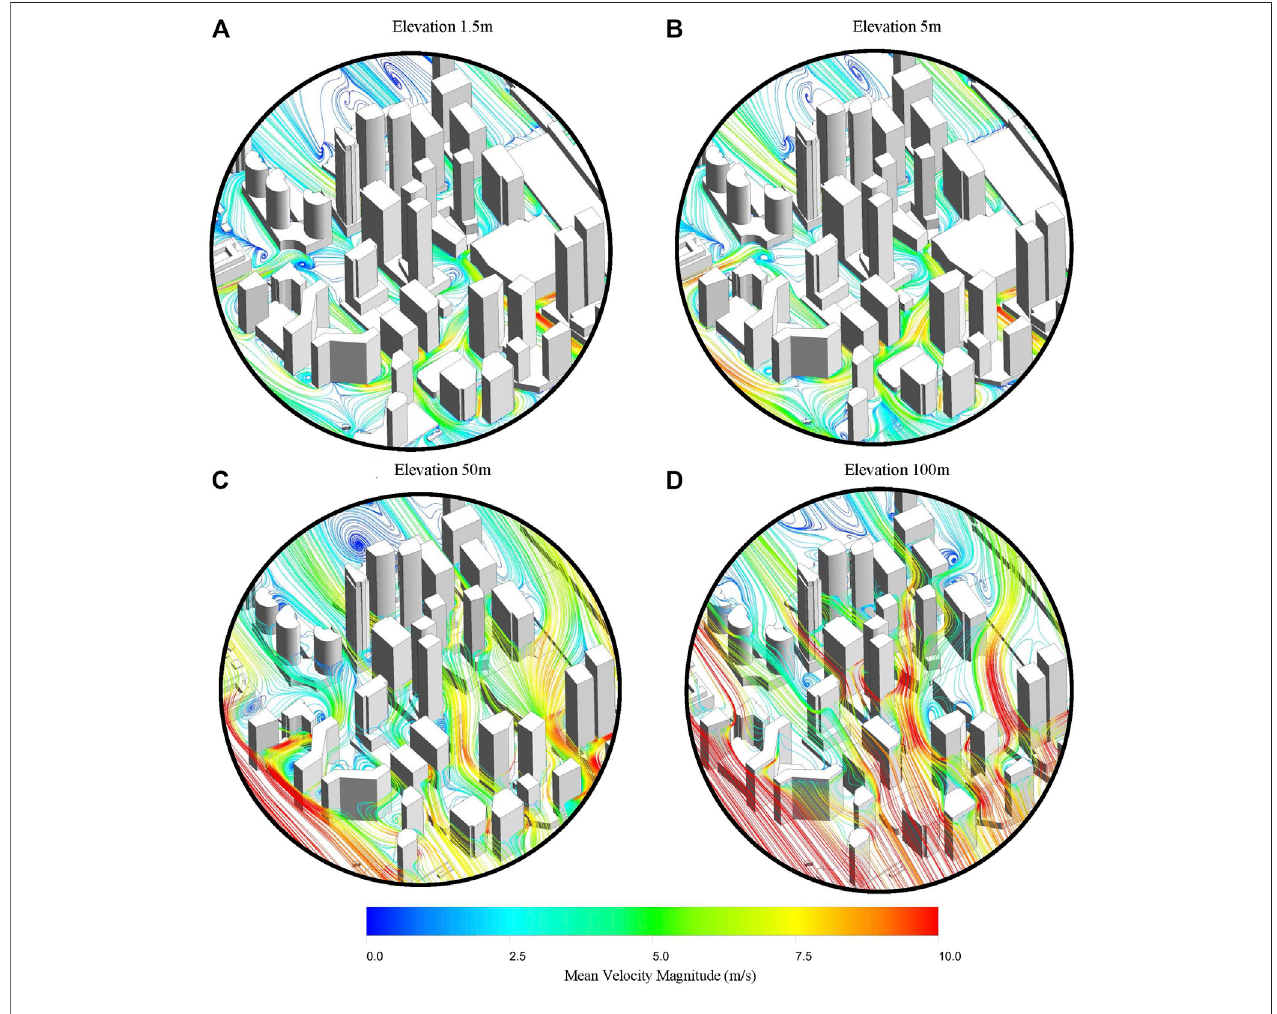
FIGURE 10 | 50G_South three Velocity Streamlines at different